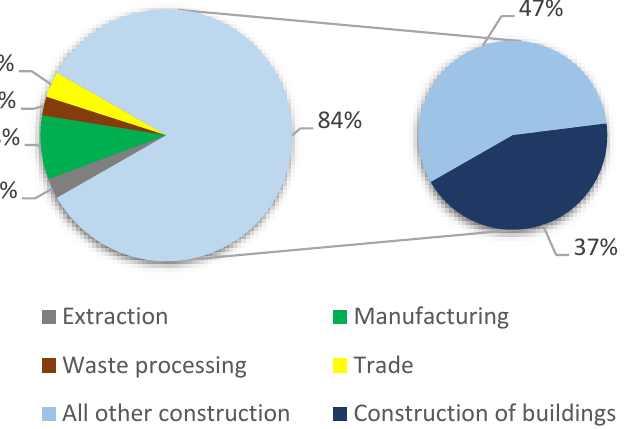
Figure 1. Shares of the stakeholder numbers in the construction sector of Kazakhstan by activity types.